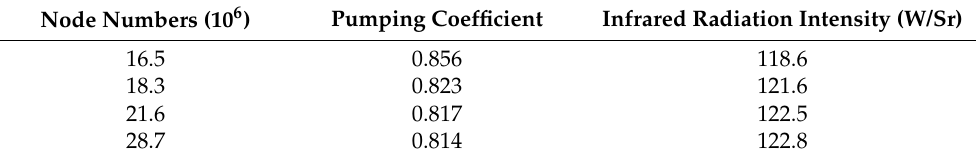
Figure 3. Computational grids in CFD. Table 2. Grid study results.